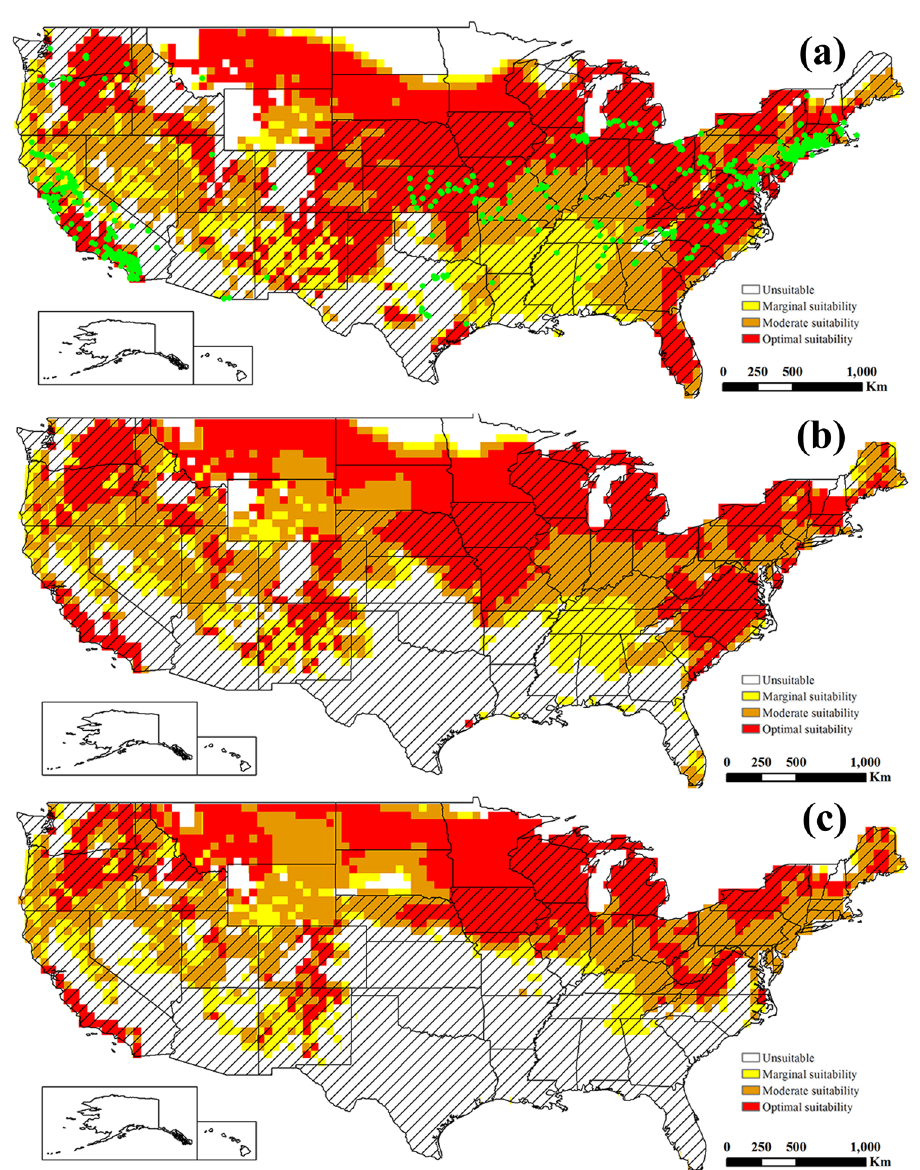
Figure 5. The potential distributions for ESC in the United States, ( a ) under the historical climate, ( b ) under the future climate change scenario RCP 8.5 by the middle of 21st century, ( c ) under the future climate change scenario RCP 8.5 by the end of 21st century. Slash indicate the distribution areas of tree-of-heaven. Green points indicate the distribution locations of tree-of-heaven. White indicates unsuitable areas (EI = 0); Yellow indicates areas of marginal suitability (0 < EI ≤ 10); Orange indicates areas of moderate suitability (10 < EI ≤ 20); Red indicates areas of optimal suitability (EI ≥ 20). The map in this figure was generated by ArcGIS 10.1 (ESRI, Redlands, CA, USA,